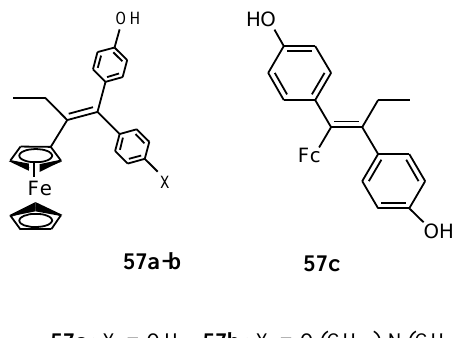
Figure 19. Chemical structures of ferrociphenol compound ( 57a – c ).